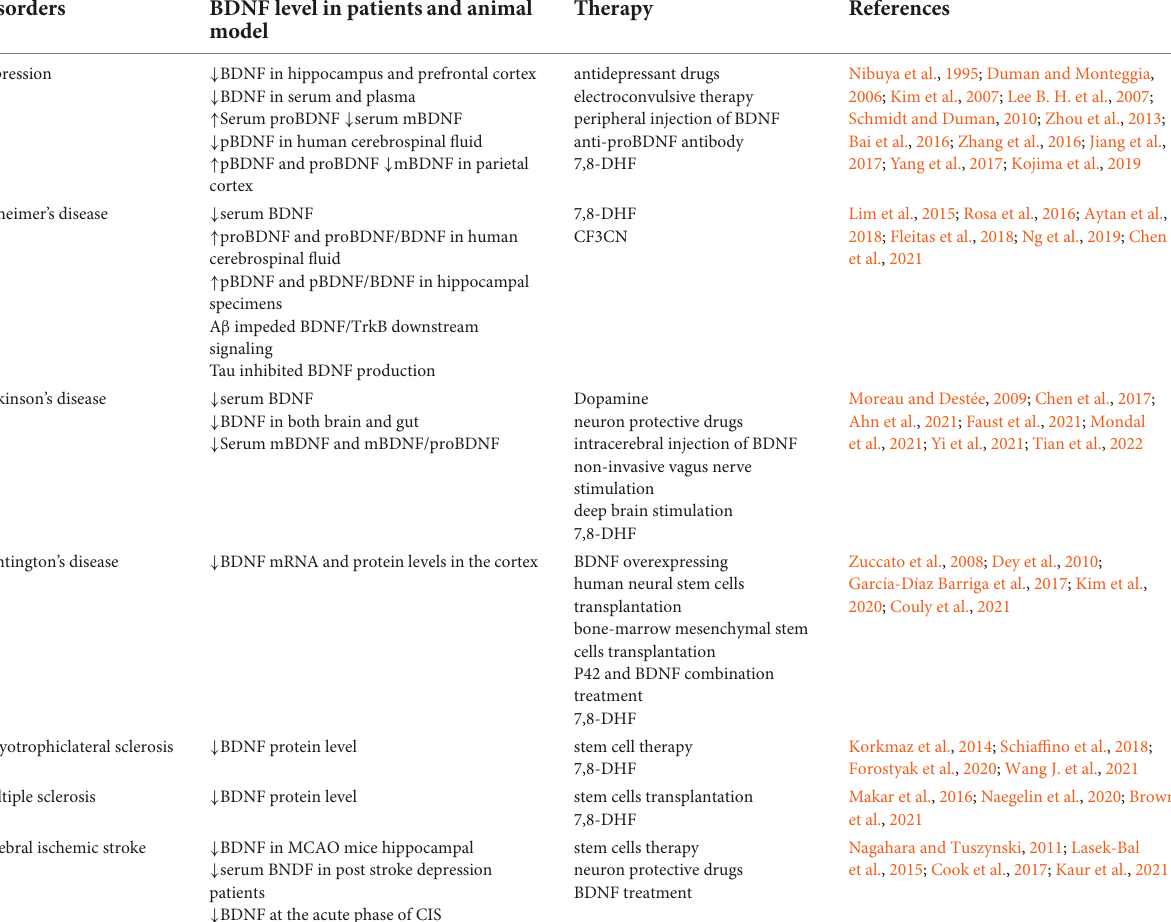
TABLE 1 Brain derived neurotrophic factor (BDNF) level in different brain disorders and BDNF associated